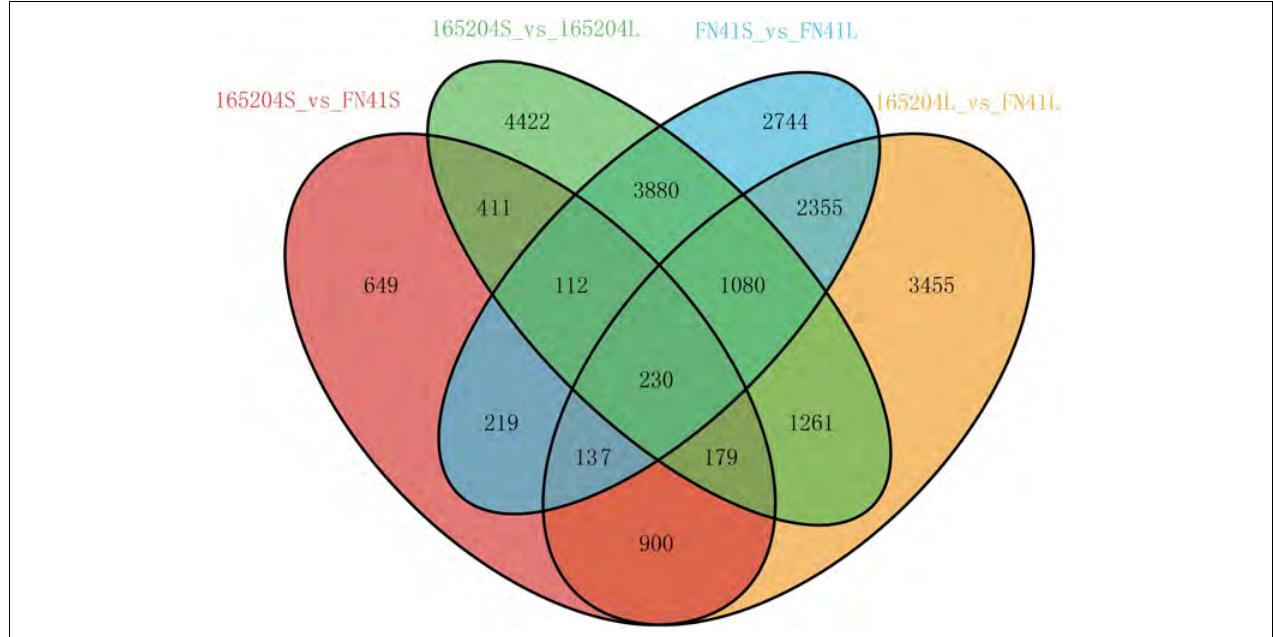
FIGURE 5 | Venn diagram of the DEGs of the four comparison groups.